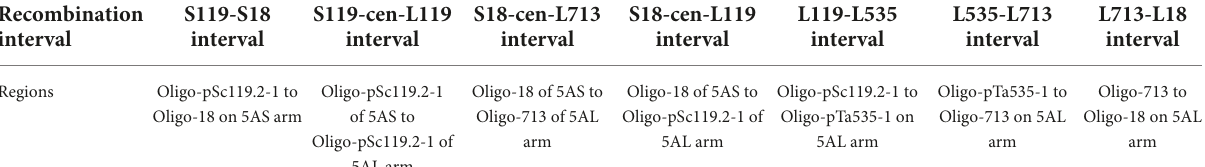
TABLE 2 Seven recombination intervals on 5A chromosome.